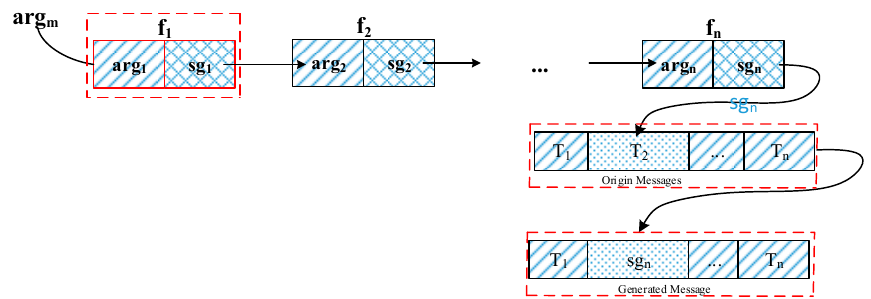
Figure 9. Message construction in the second category.